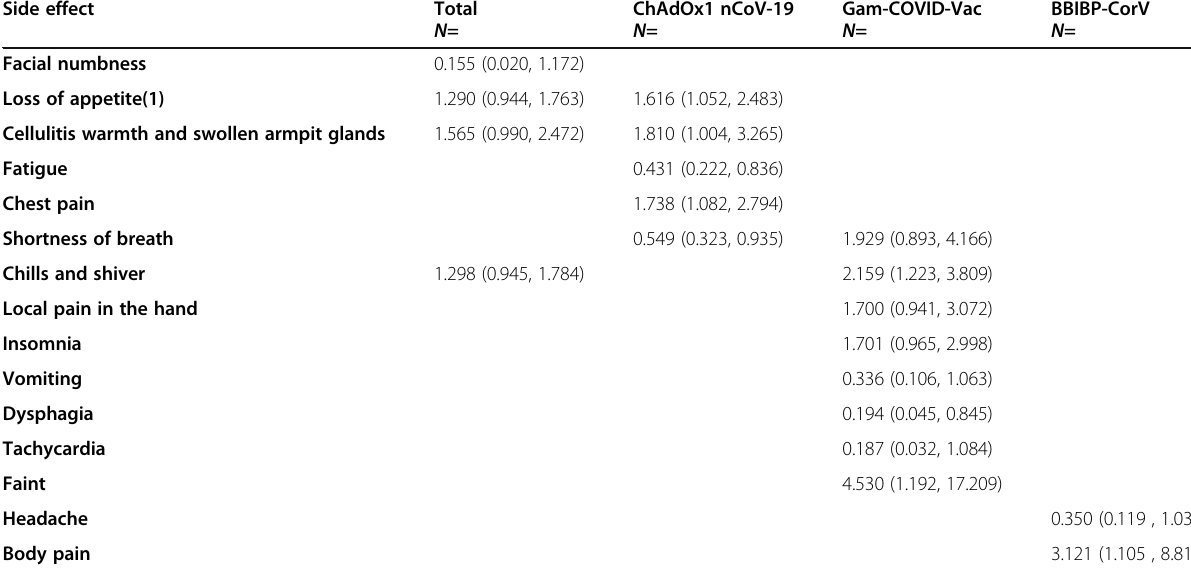
Table 3 The data regarding patients with/without a history of SARSCoV-2 infection Side